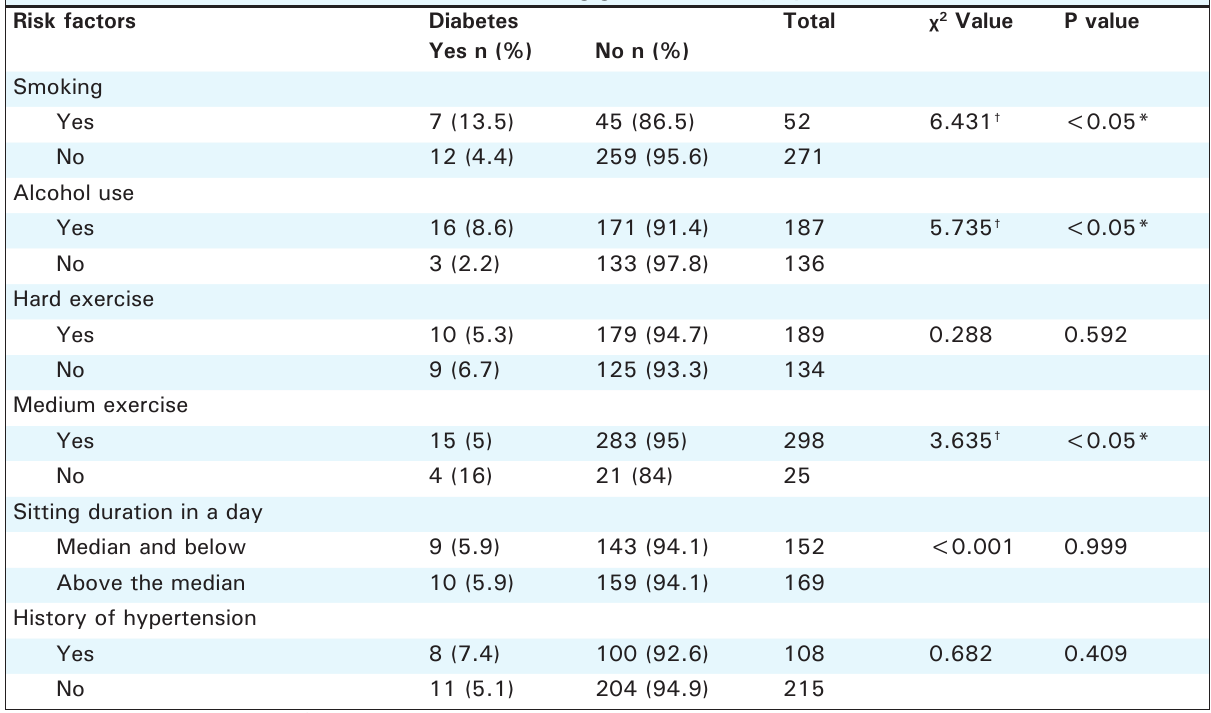
Table 3. Association of risk factors for diabetes among government employees.